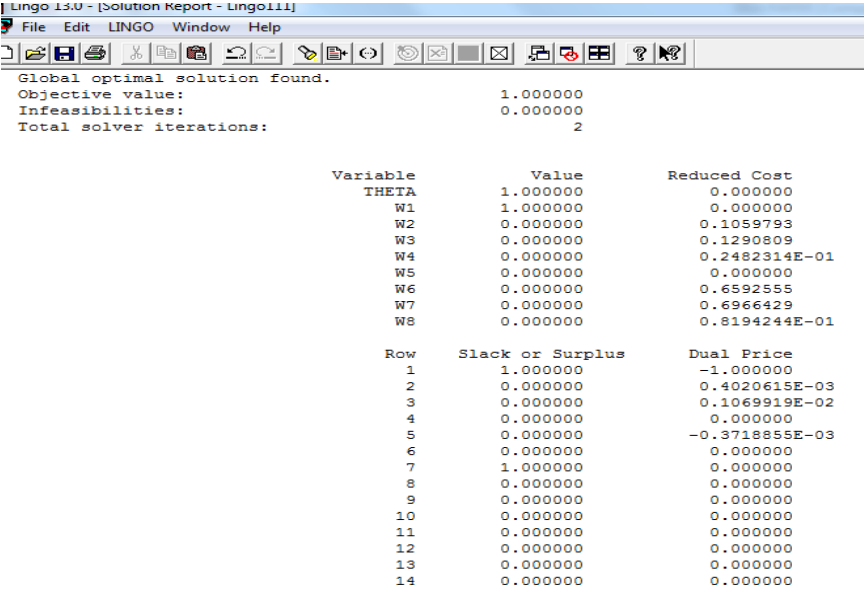
Fig. 3. Output of Lingo software of DMU1 during pre-demonetization (developed by the